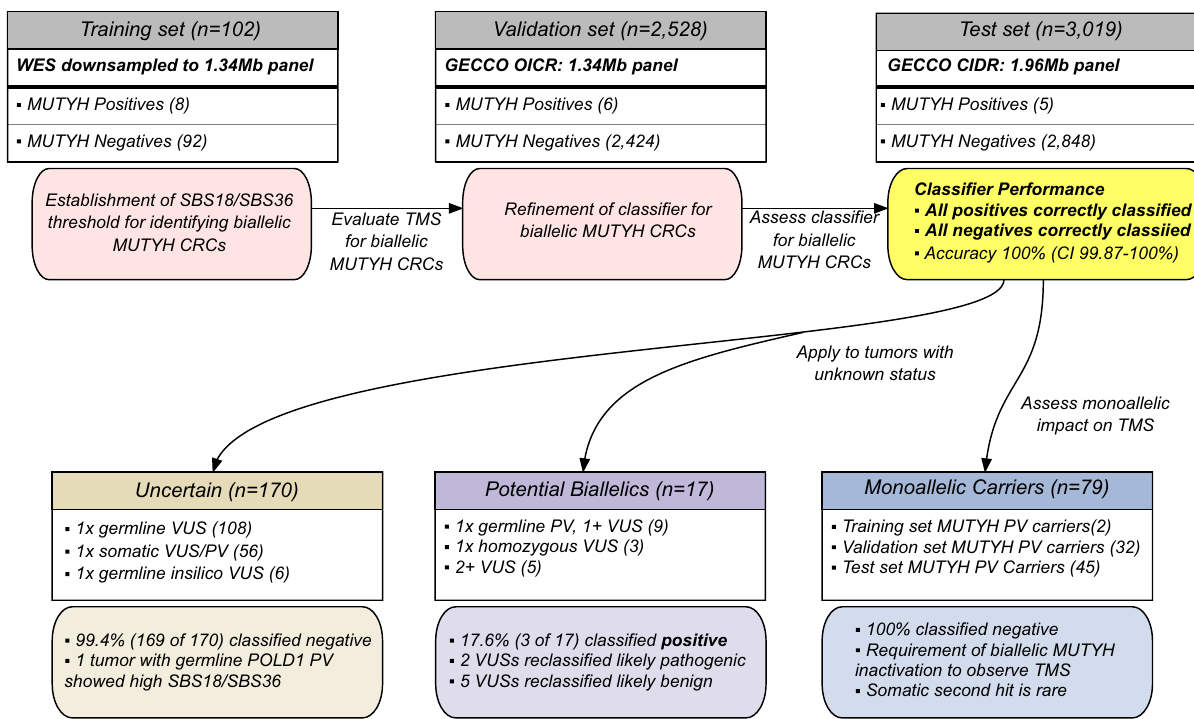
Fig. 1 Overview of the analysis steps and groups of CRC tumor sequencing data included in the study, totaling 5649 CRCs. The SBS18/SBS36 TMS threshold was established using 102 CRCs down-sampled from whole-exome sequenced (WES) to intersect with the 1.34 Mb capture used to sequence the CRC tumors in the validation set. The 2528 CRCs sequenced with 1.34 Mb capture as part of the validation set were used to re fi ne the SBS18/SBS36 classi fi er by including the somatic mutation count and TMS reconstruction error. The accuracy of the re fi ned classi fi er was assessed using 3019 CRC tumors sequenced with a 1.96 Mb capture as part of the test set. The re fi ned classi fi er was subsequently applied to 79 CRCs from monoallelic MUTYH pathogenic variant carriers, and CRCs de fi ned as potential MUTYH biallelics and MUTYH uncertain status to determine its utility in variant classi fi cation. CI con fi dence interval, CIDR Center for Inherited Disease Research, CRC colorectal cancer, GECCO Genetic Epidemiology of Colorectal cancer Consortium, Mb megabase, OICR Ontario Institute of Cancer Research, PV pathogenic variant, SBS single bases substitution, TMS tumor mutational signature, VUS variant of uncertain clinical signi fi